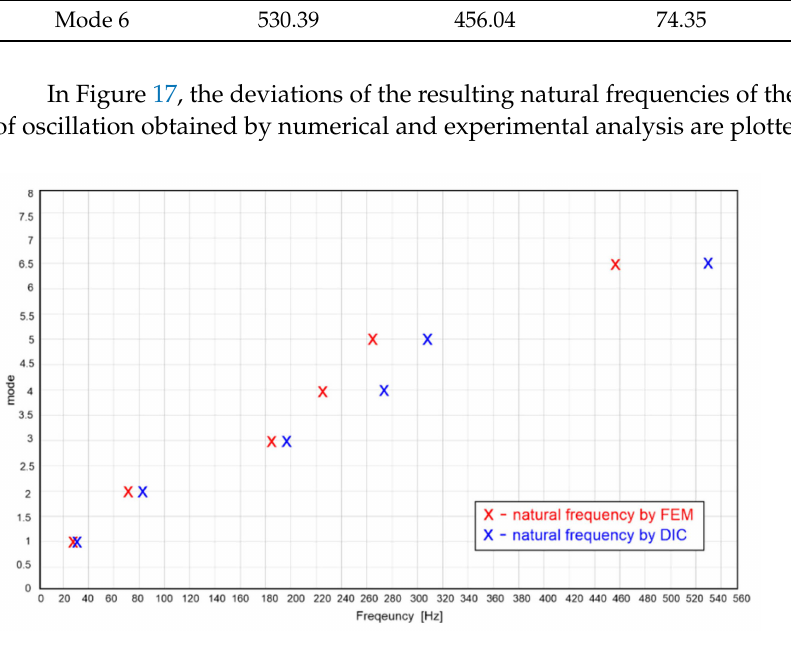
Figure 17. Comparison of eigenfrequency results obtained by EMA analysis and FEM